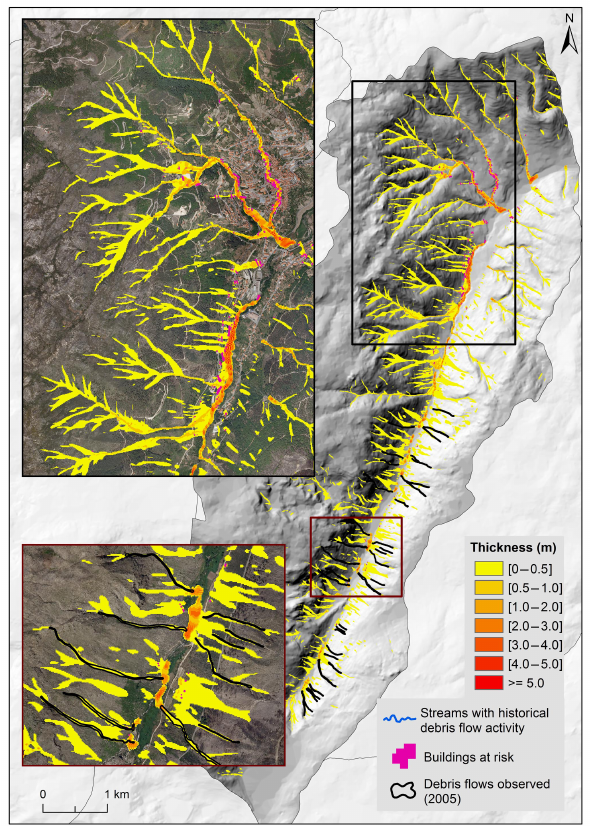
Figure 12. Debris flow run-out modeling on the basin scale, con- sidering excess rain of 40mmh − 1 (Scenario